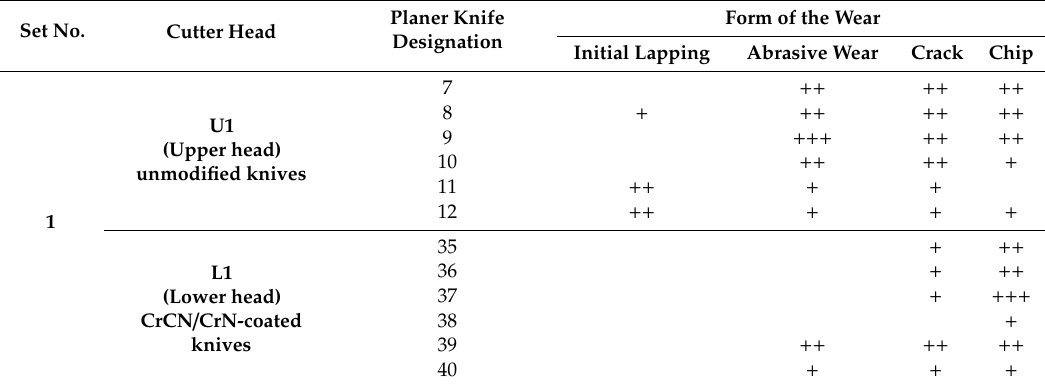
Table 4. Forms of wear observed on the rake face of the analyzed industrial planer knives. Set